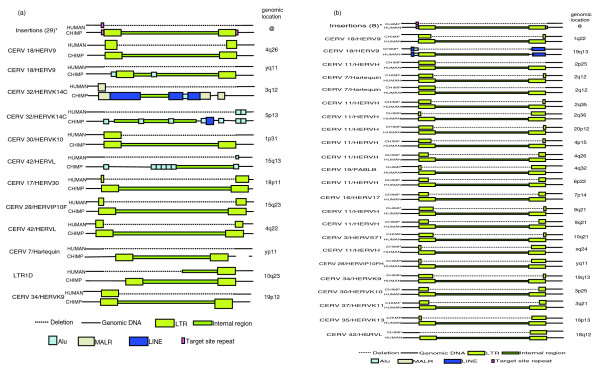
Structure of endogenous retroviral INDEL sequences (>5,000 bp) in humans and chimpanzees. (a) Characteristics of the remnant endogenous retroviral sequences (solo LTRs and/or fragmented elements) in humans. The asterisk indicates 29 chimpanzee specific endogenous retroviral insertions of which: 25 belong to the CERV 1/PTERV1 family (at genomic locations 5p12, 1q25, 12p13, 10q11, 3q11, 14q23, 2p11, 12p11, 4q13, 5q11, 3p22, 11p12, 13q12, 6q25, 7p14, 16p13, 7p21, 3q12, 12q12, 4p12, 5p14, 10q21, 7p14, 7p11, 5q12; 2 belong to the CERV 2 family (at genomic locations 3p24, 19q13); 1 belongs to the CERV 3 (HERVS71) family (at genomic location yp11]; and 1 belongs to the CERV 30 (HERVK10) family (at genomic location 12p13) (Table 3). (b) Characteristics of the remnant endogenous retroviral sequences (solo LTRs and/or fragmented elements) in chimps. The asterisk indicates 8 human specific endogenous retroviral insertions from the CERV 30 (HERVK10) family at genomic locations 22q11, 3q13, 3q27, 5q33, 6q14, 10q24, 11q22, 12q14 (Table 4).